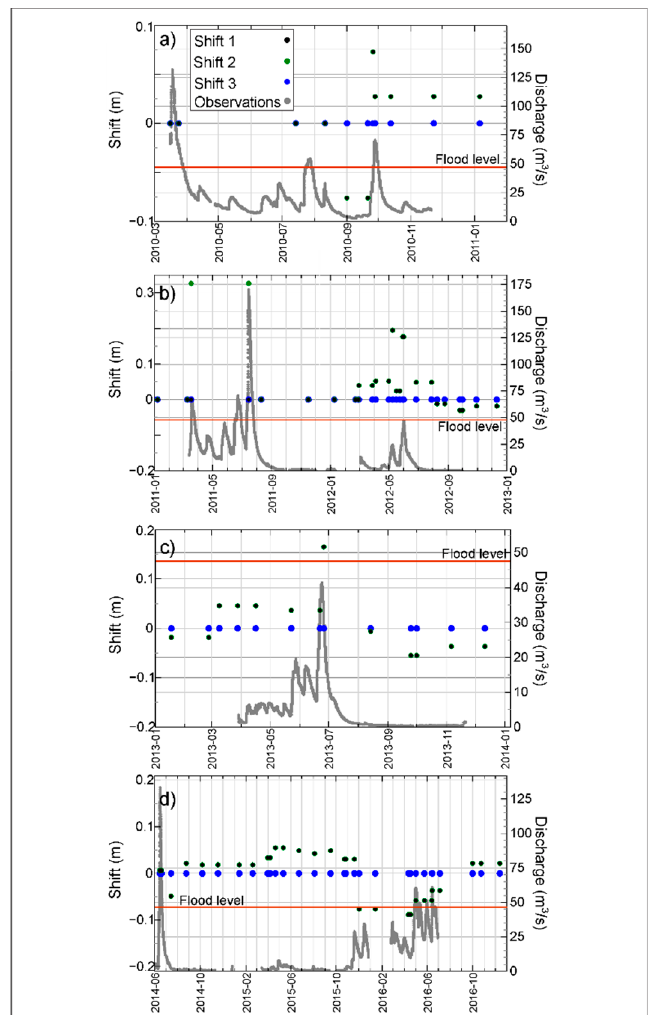
Figure 10. Shift values plotted with hydrograph data in Little Sioux River near Spencer. Black, green, and blue dots represent the shift values applied to the section, channel, and overbank control areas, respectively. ( a ) Hydrograph for base rating curve #1.0; ( b ) hydrograph for base rating curve #2.0; ( c ) hydrograph for base rating curve #2.1; and ( d ) hydrograph for base rating curve #3.